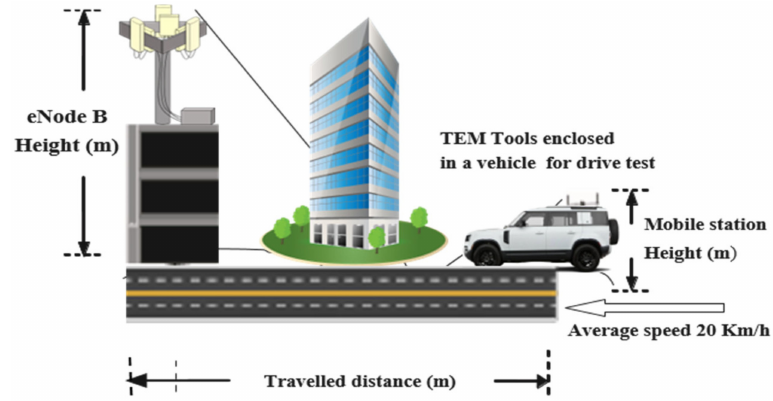
Figure 1. Illustration of the TEMS Drive Test Measurement System.